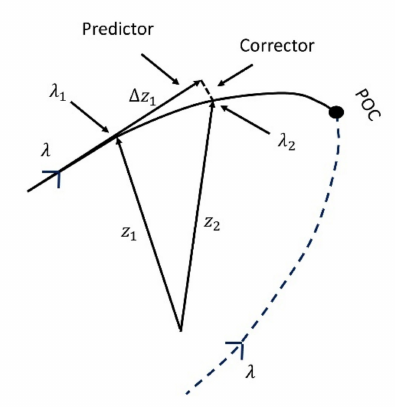
Figure 3. Illustration of continuation method